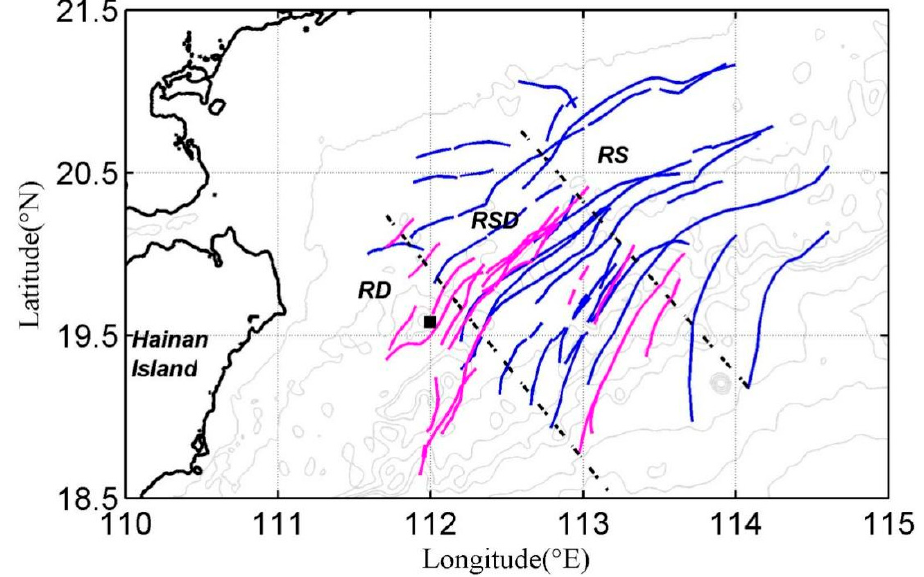
Figure 4. A general distribution pattern of the NLIWs. The blue lines represent type-S waves and the magenta lines represent type-D waves. The two dashed lines depict the boundaries for the distribution of the two types of NLIWs. The filled black square denotes the mooring position of Xu et al. [16].